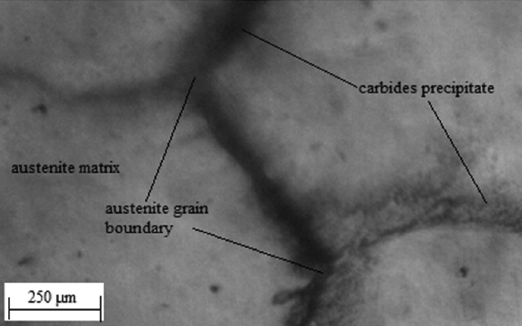
Figure 13. Optical micrograph of heat treated sample in water bath without agitation. The microstructure shows carbides precipitate along austenite grain boundaries.